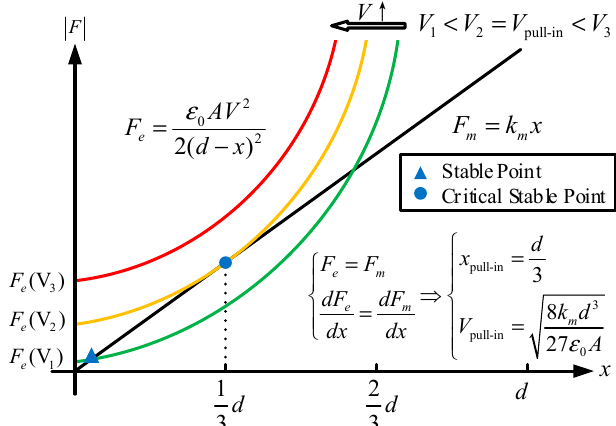
Figure 3. Derivation for the pull-in voltage.